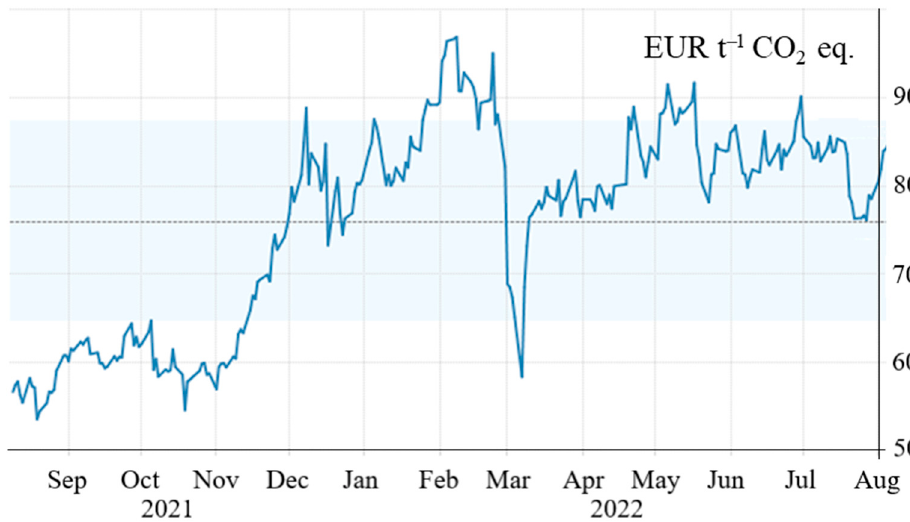
Figure 2. The EEAP variation.